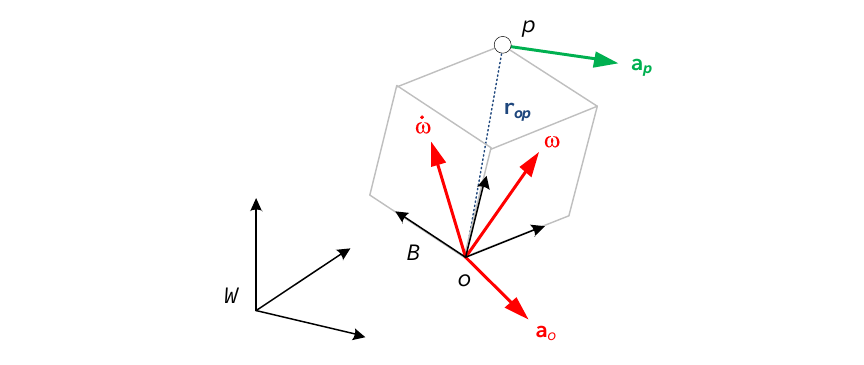
Figure 1. General description of the accelerated body in the inertial frame.